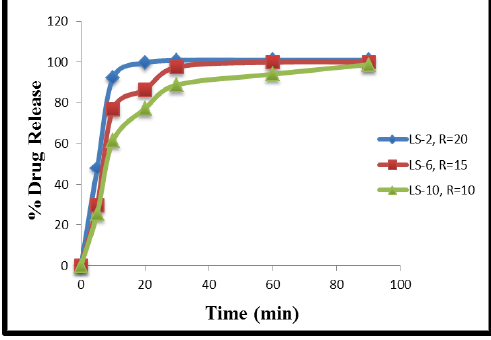
Figure 19. Effect of excipient ratio (R) on dissolution profile of clopidogrel liquisolid compacts in phosphate buffer (pH 6.8) with 1% SLS at